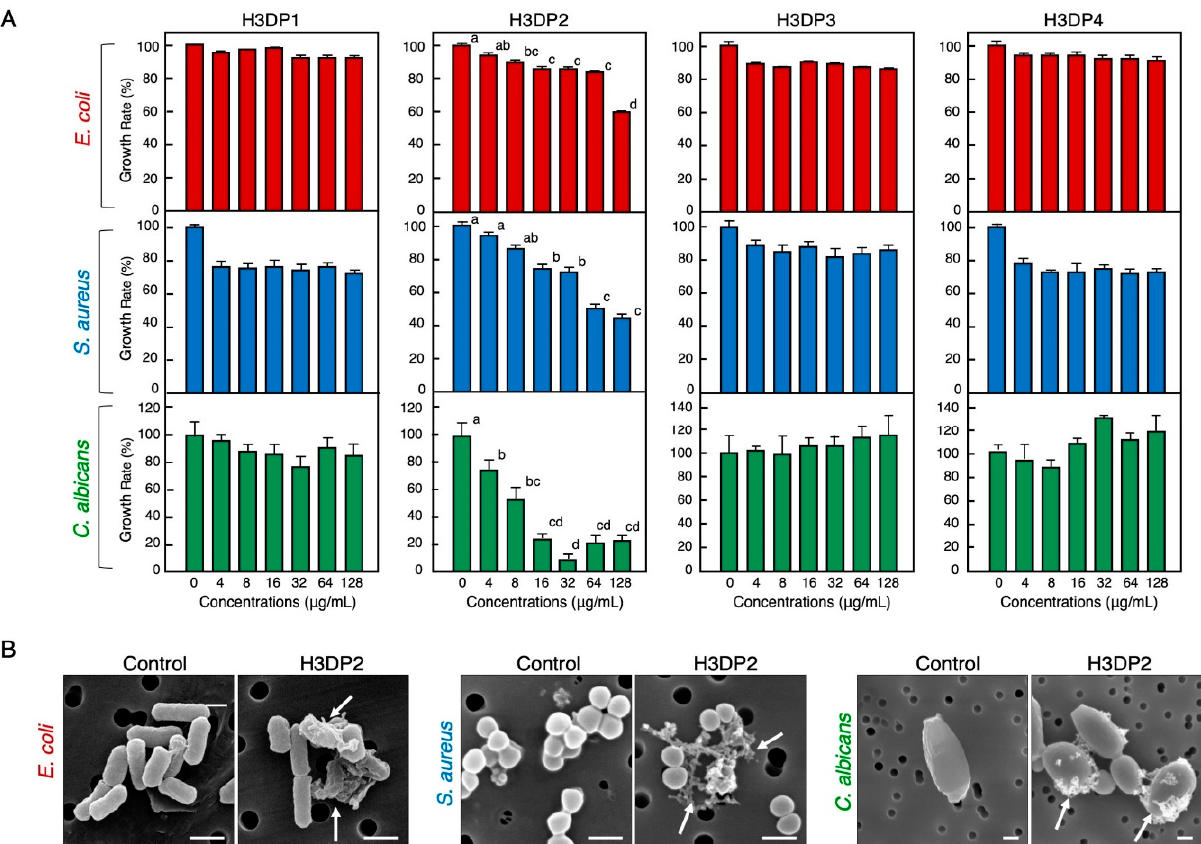
Figure 5. Effects of various concentrations of the four histone H3-derived peptides, H3DP1–4, on the growth of pathogenic bacteria E. coli and S. aureus and fungus C. albicans ( A ). Cells of each microbial strain were incubated with two-fold serially diluted H3DP1, H3DP2, H3DP3, or H3DP4 for 18 h ( E. coli, S. aureus ) or 24 h ( C. albicans ) at 37 °C. Each column and vertical bar represent the mean and standard error of the mean, respectively ( n = 4). In all panels, values with the same letters are not significantly different ( p ≥ 0.05). Scanning electron microscopy examination of bacteria and fungi following the treatment with H3DP2 ( B ). Aliquots of E. coli , S. aureus , or C. albicans cultures at the mid-logarithmic growth phase were incubated with H3DP2 or myoglobin (negative control) at 64 µ g/mL for 1 h at 25 ◦ C. Abnormally shaped cells similar to those observed in Figure 2 are visible in each panel (arrows). Bars, 1 µ